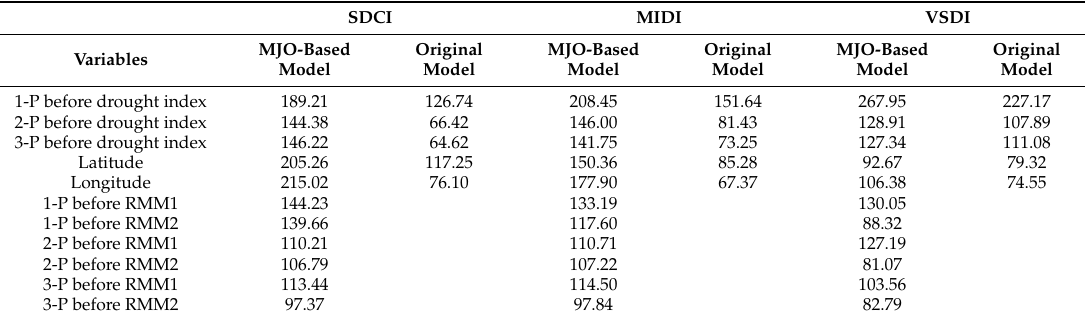
Table 2. Variable importance of two drought prediction models (with MJO and without MJO) for three drought indices. SDCI MIDI VSDI Variables MJO-Based Model Original Model MJO-Based Model Original Model MJO-Based Model Original Model 1-P before drought